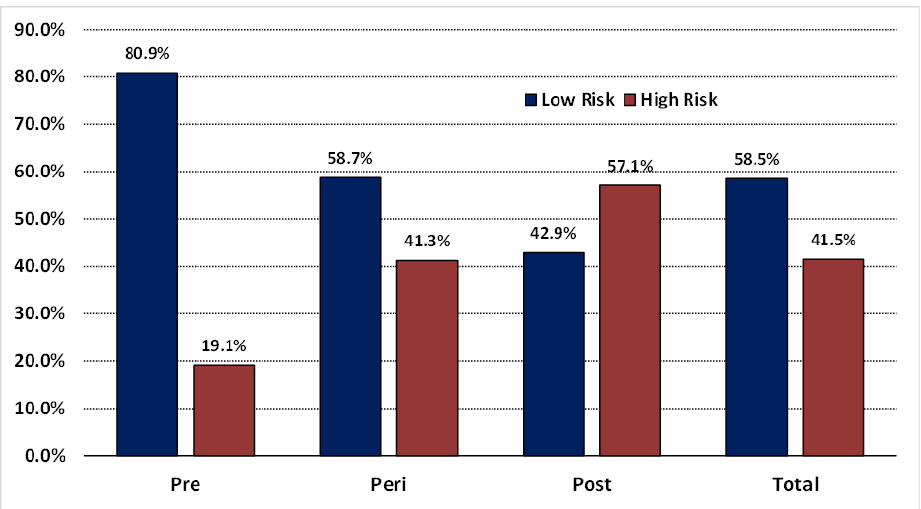
Figure 2. The distribution of low-risk and high-risk lipoprotein(a) levels among premenopausal, perimenopausal, and postmenopausal women; Lp(a) cut-off value is 30 mg/dL. Note: Data are presented as the percentage of low-risk Lp(a) level and high-risk Lp(a) level among menopausal groups. Lipoprotein(a) cut-off value is 30 mg/dL. The low-risk group’s Lp(a) concentration is below 30 mg/dL. The high-risk group’s Lp(a) concentration is above 30 mg/dL. Abbreviations: Pre: premenopausal women; Peri: perimenopausal women; Post: postmenopausal.